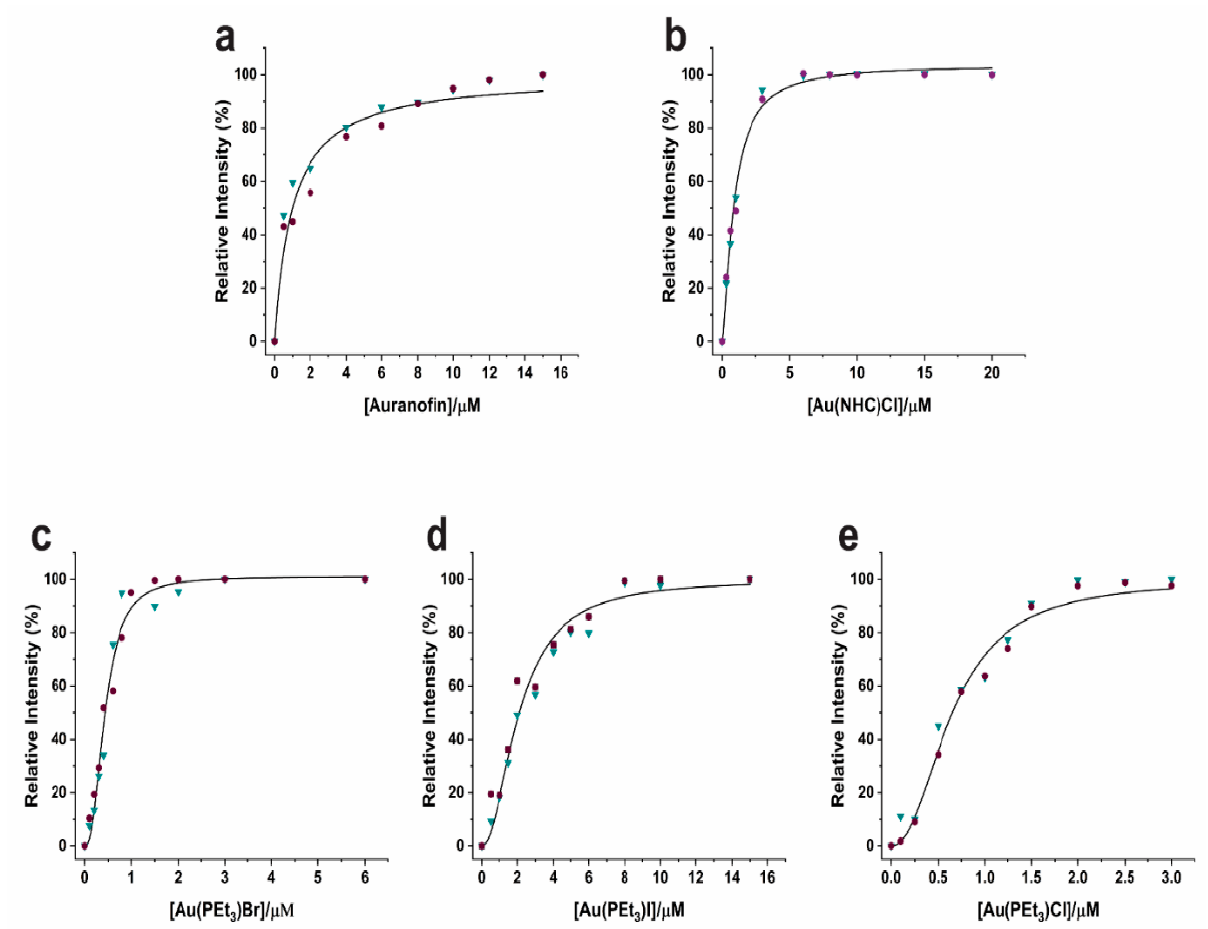
Figure 2. Inhibition M pro profiles by ( a ) Auranofin ( b ) Au(NHC)Cl ( c ) Au(PEt 3 )Br ( d ) Au(PEt 3 )I ( e ) Au(PEt 3 )Cl. Two independent measurements are shown as red dots and blue triangles, respectively. K i values were determined by nonlinear regression. Table 1. Inhibition constants, K i values, measured for the interaction between gold compounds and M pro.